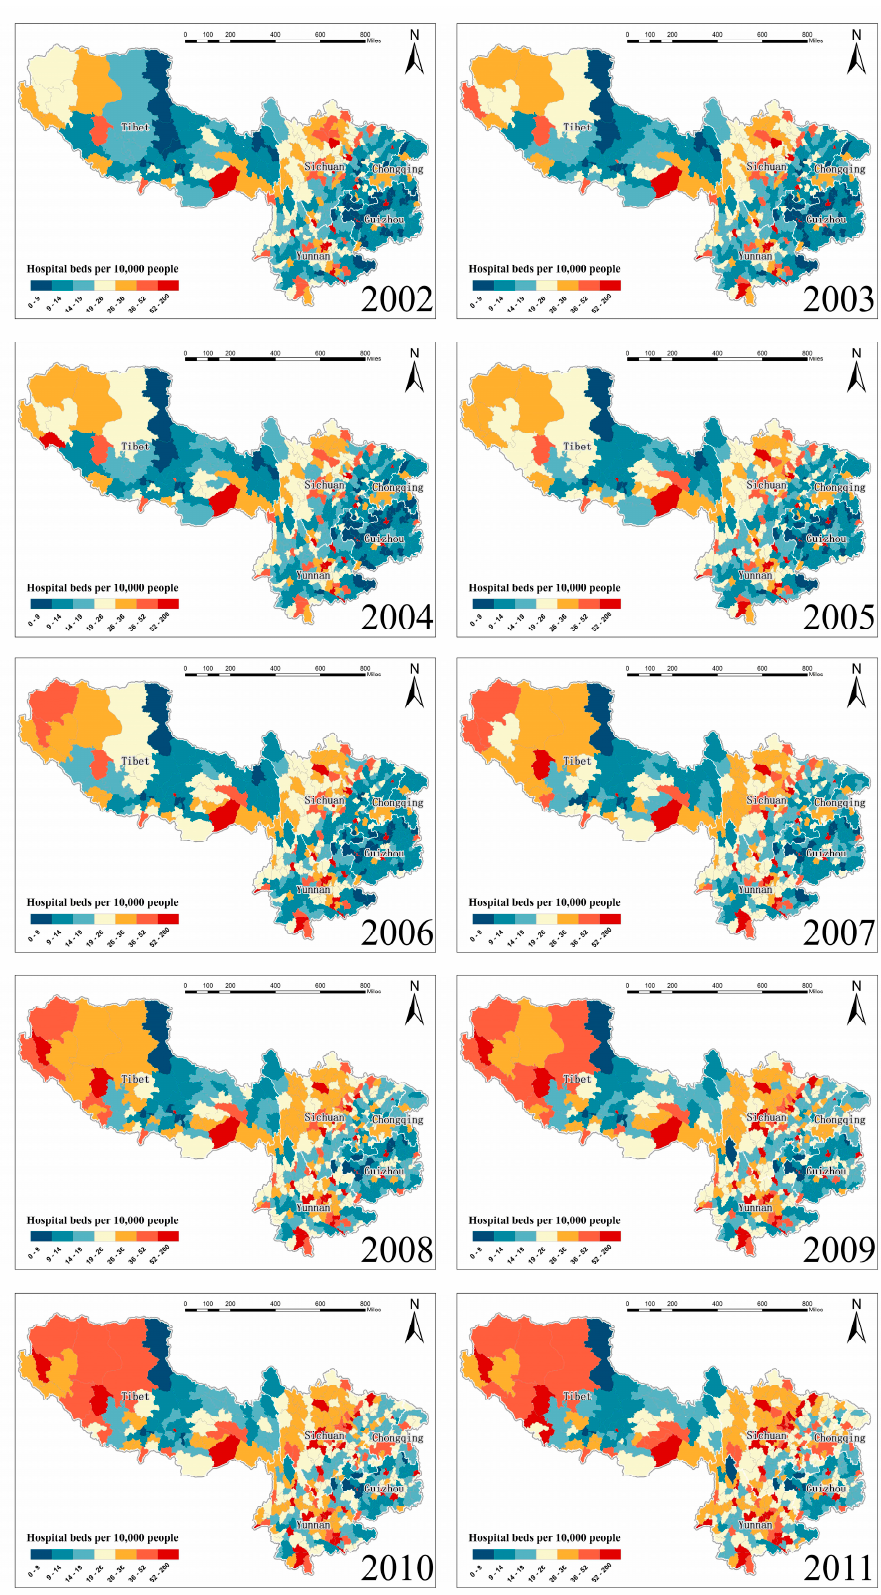
Figure 6. Estimated spatiotemporal equalities maps of the county-level healthcare resources of hospital beds across southwest China from 2002 to